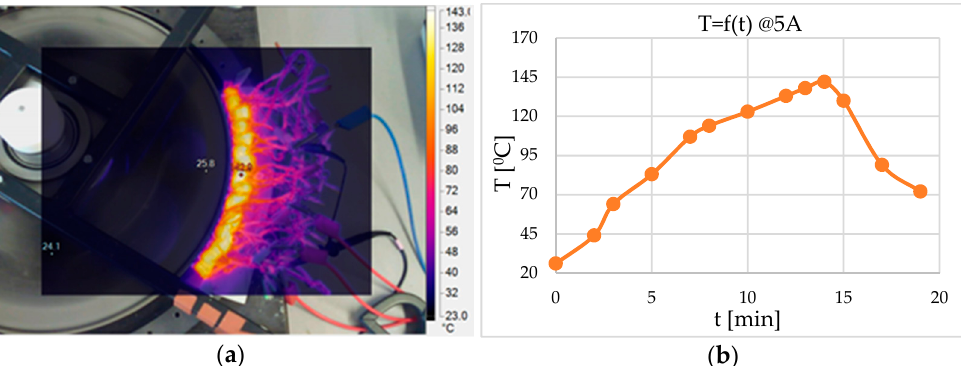
Figure 11. Heating process of segment: ( a ) IR Image at 14 min of 3xIn load, ( b ) characteristic of winding temperature on its surface.